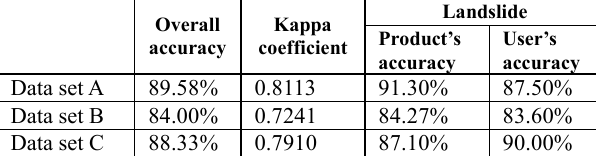
Table 4. The accuracy analysis of the landslide extraction